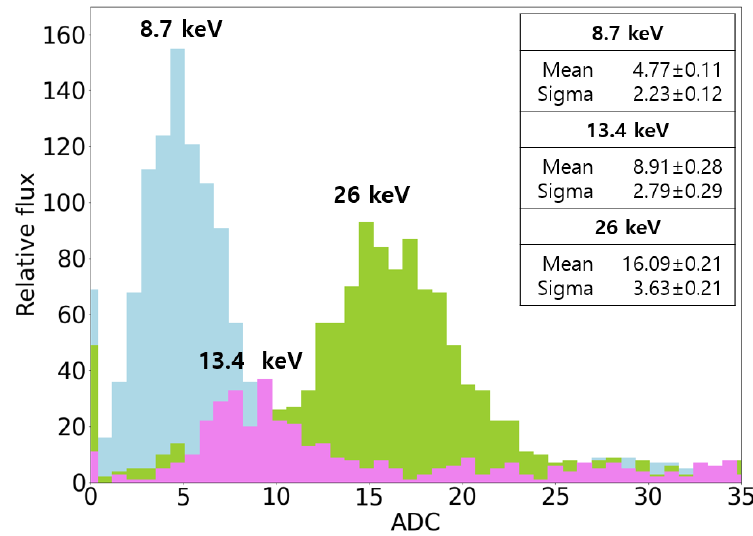
Figure 3. Energy measurements of a UBAT in terms of ADC counts using the Amptek X-ray tube with an Au target. Voltages applied to the tube were 10, 15, and 30 kV for energies of 8.7, 13.4, and 26 keV, respectively. In addition, for energies of 13.4 keV and 26 keV, an Mo filter with a thickness of 0.025 mm and a Cu filter with a thickness of 0.3 mm were used, respectively.